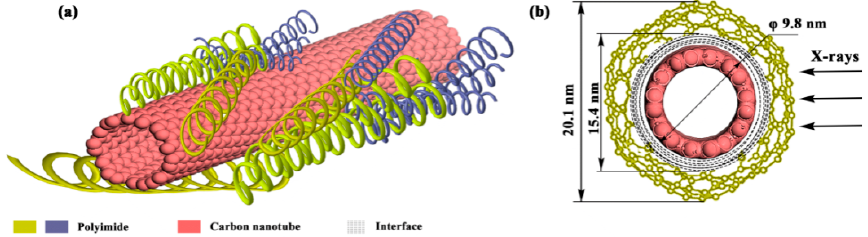
Figure 7. Diagram of MWNT / PI nanocomposites of ( a ) a MWNT wrapped in PI long molecular chains in a period and ( b ) the cross section of nanocomposite when X-ray incident from the side direction.